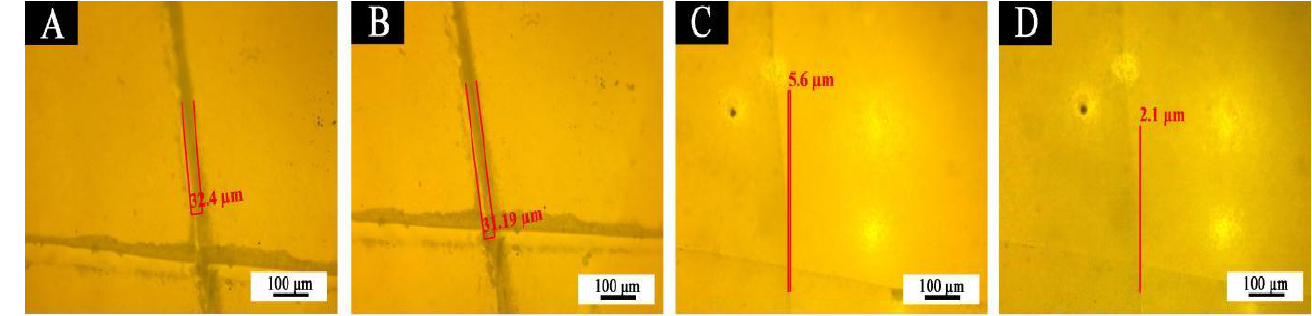
Figure 14. OM images of film: before healed ( A ) 11#, ( C ) 7#, after healed ( B ) 11#, ( D ) 7#.